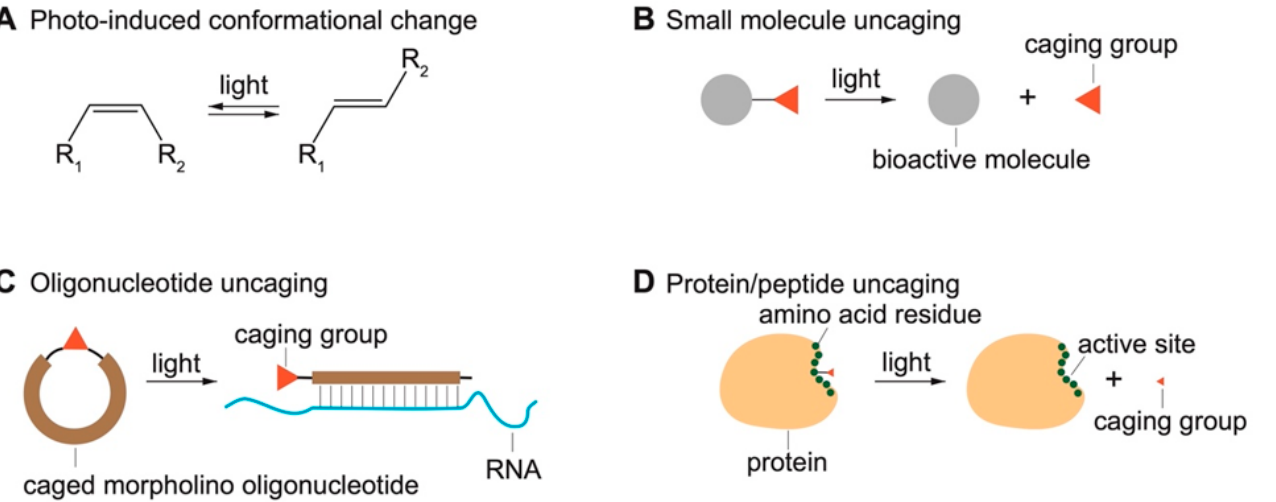
Figure 1. Common strategies to design opto-chemical tools. ( A ) Photo-induced conformational change which is usually reversible. Photo-induced isomerization is shown as an example. ( B ) Photo- uncaging of small molecules. ( C ) Photo-uncaging of oligonucleotides. Cyclic caged morpholino is shown as an example. ( D ) Photo-uncaging of peptides and proteins of which single amino acid residues can be caged.